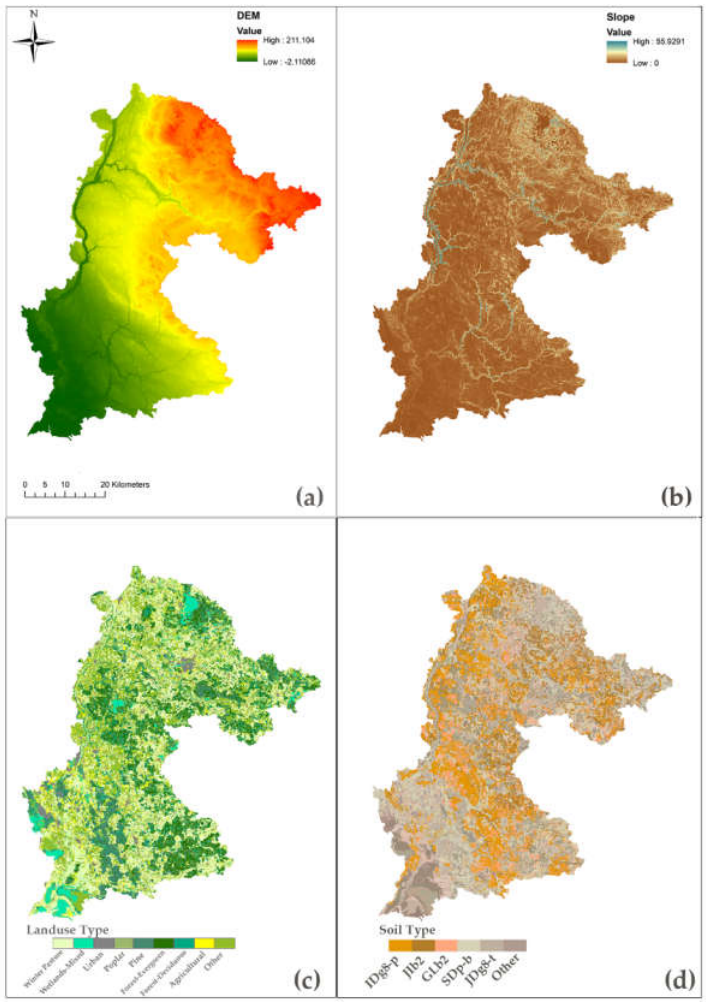
Figure 2. Minija river watershed characteristics: ( a ) DEM; ( b ) slope; ( c ) land use; and ( d ) soil